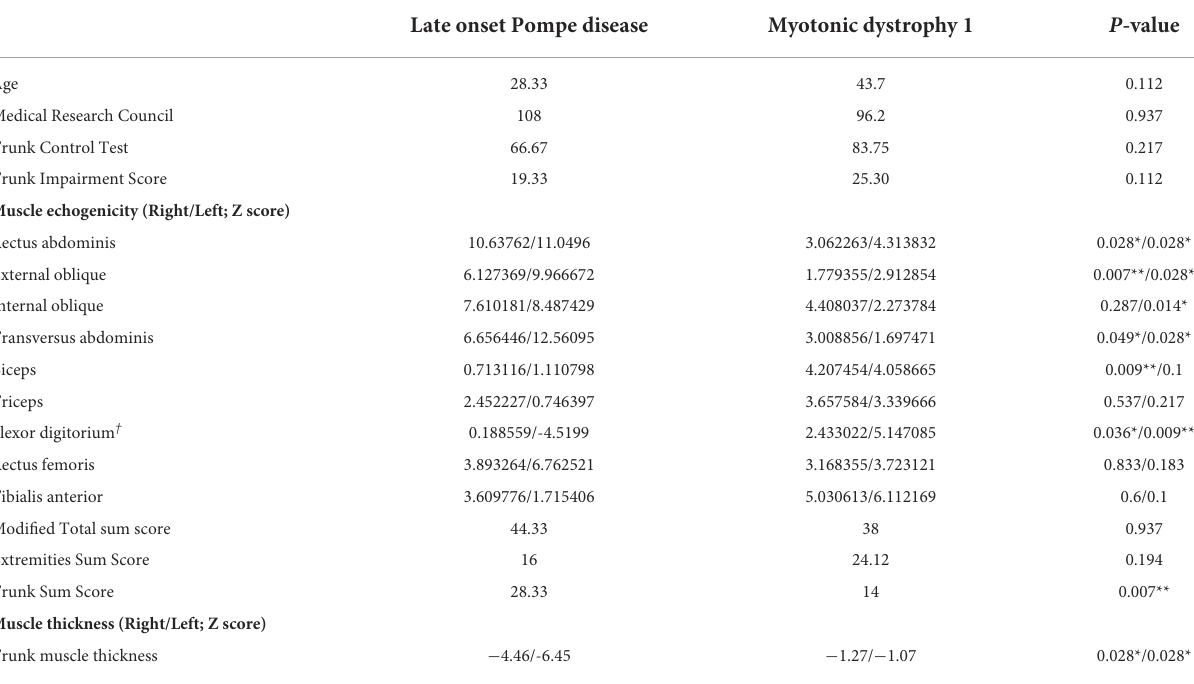
TABLE 2 Quantitative echogenicity and abdominal muscle thickness in muscular